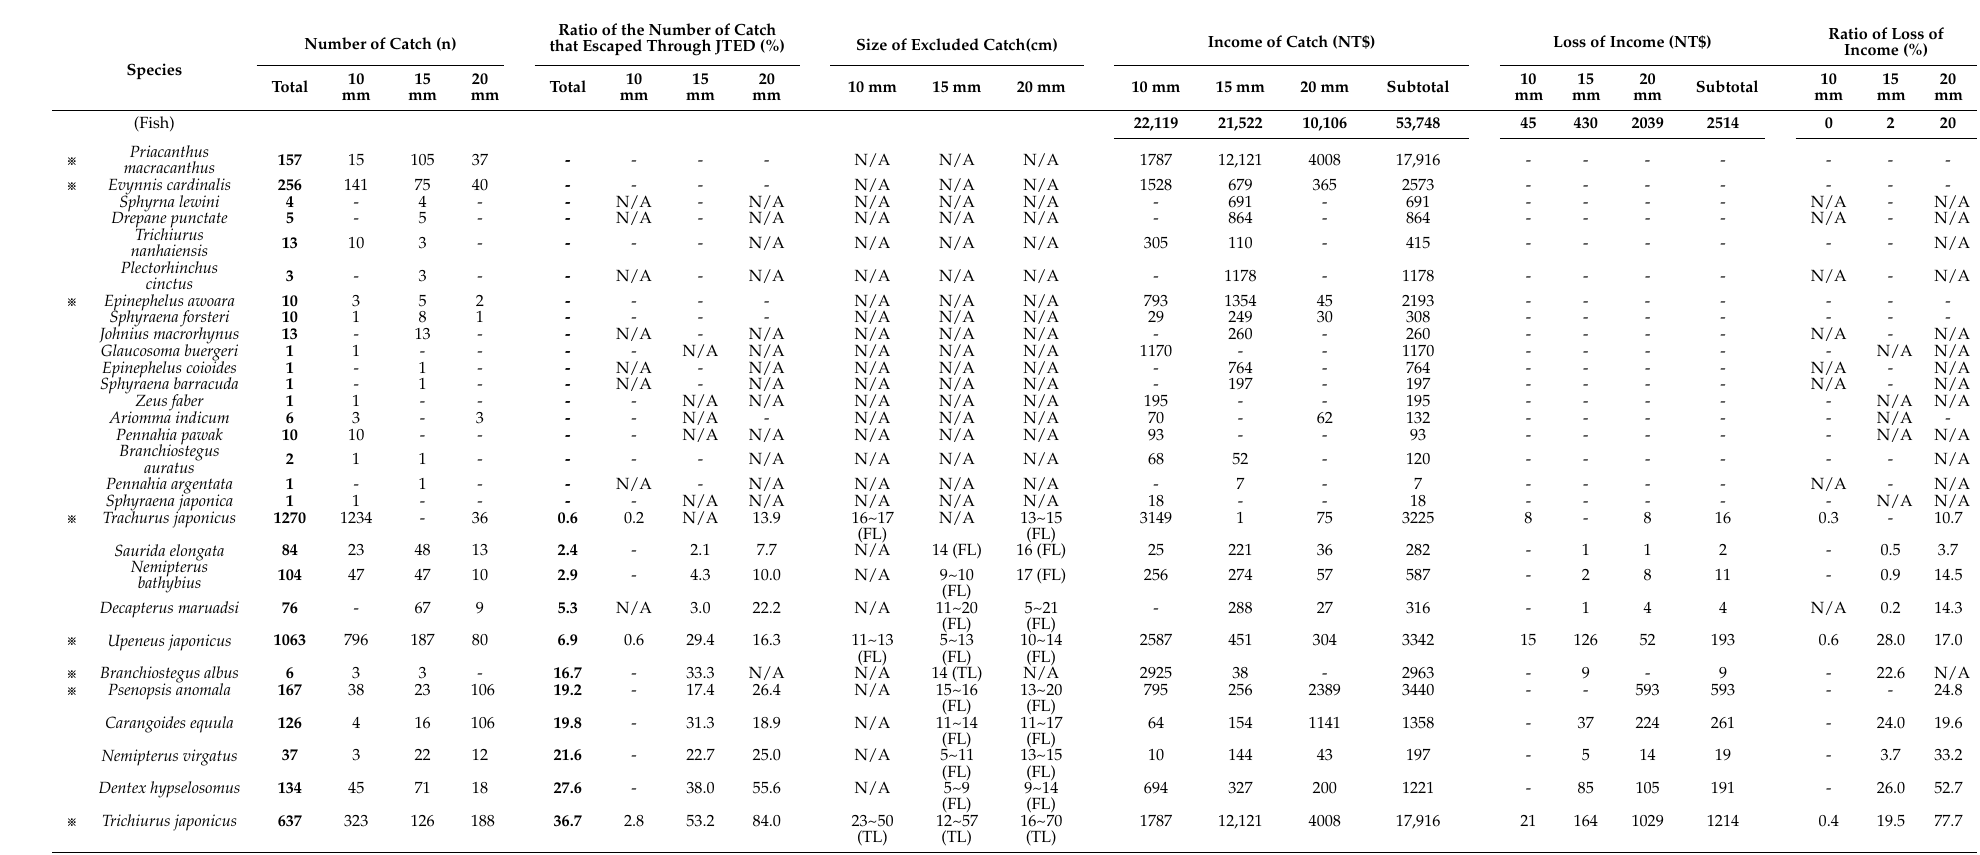
Table 3. Main marketable catches excluded by JTEDs and the associated loss in